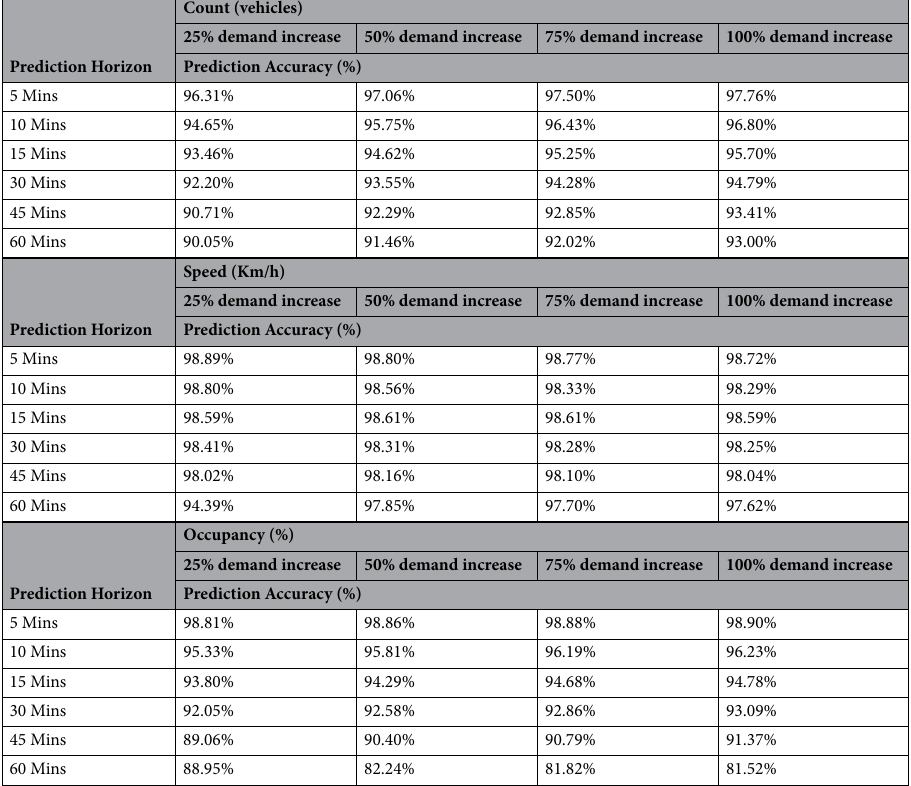
Table 6. Summary of results for all scenarios for count, speed and